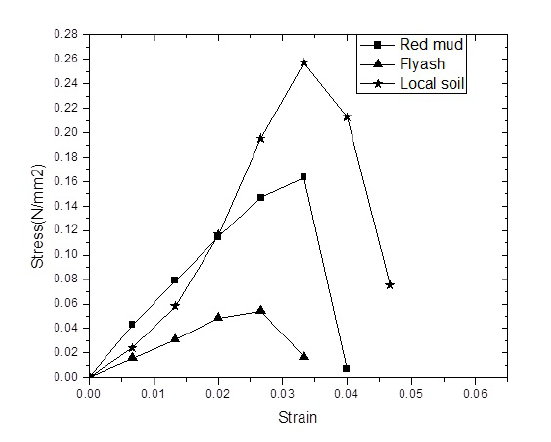
Figure 6. Stress- strain curve of red mud, fly ash and